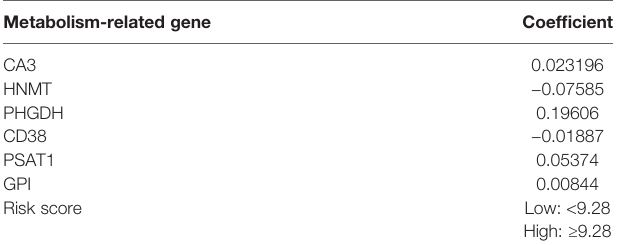
TABLE 2 | Hub genes and correlated coef fi cient value.